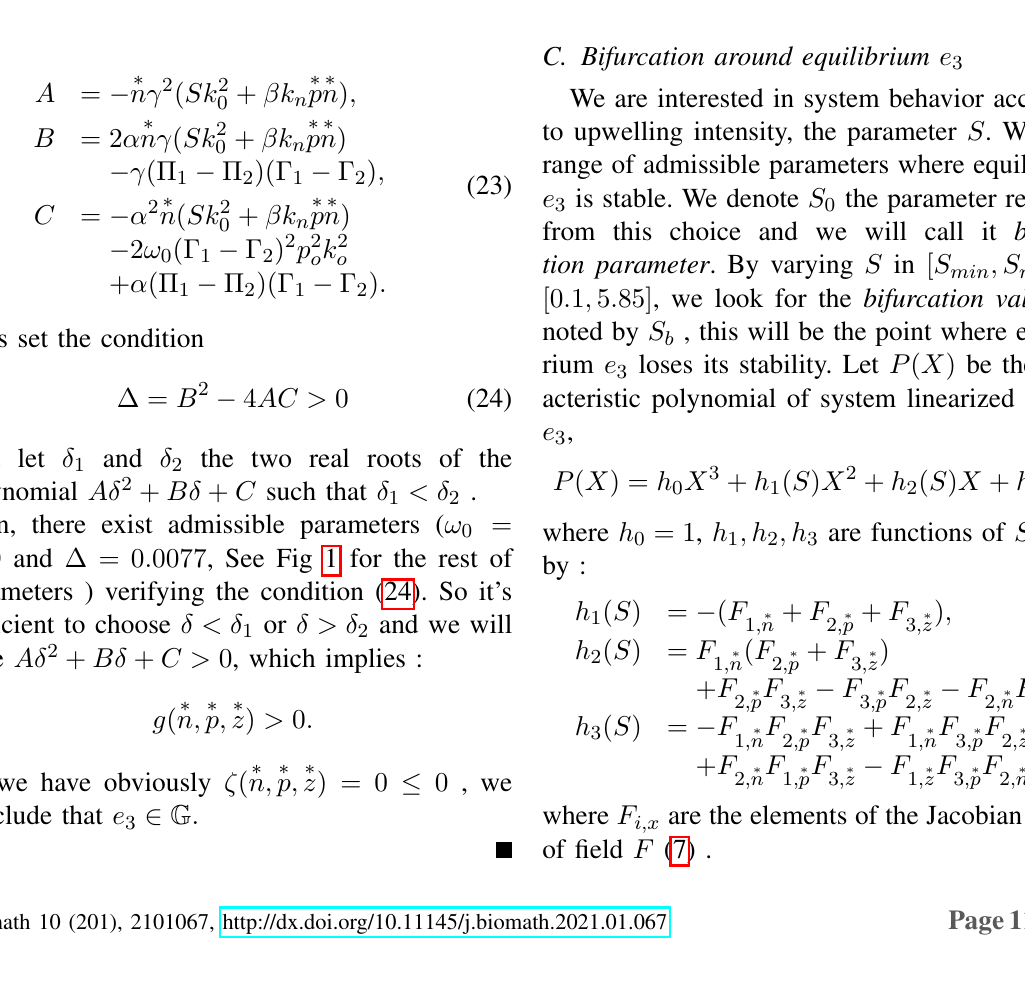
Fig. 2: (a) - Bifurcation diagram illustrating the bifurcation value S parameters , (c)- Eigenvalues in red for S < S b and in blue for S > S b